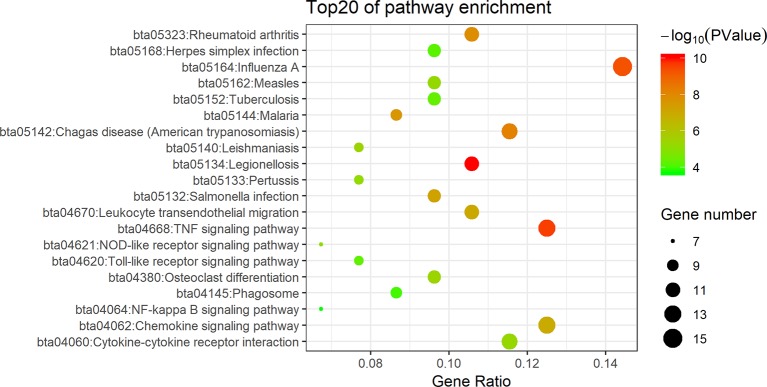
Signaling pathway analysis of DEGs associated with E. coli mastitis. The Kyoto Encyclopedia of Genes and Genomes (KEGG) pathways enrichment of DEGs was performed using the online biological tool DAVID with gene ratio, gene number, and P value.